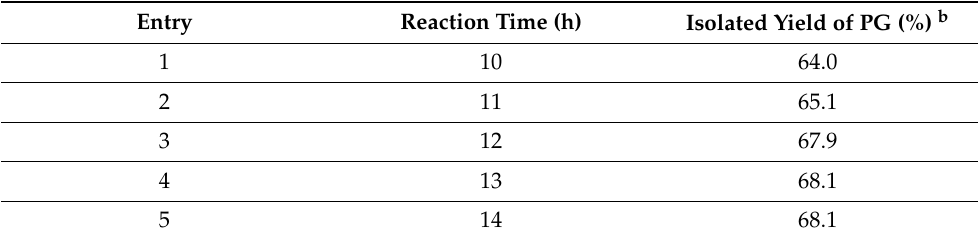
Table 3. Effect of the reaction time on the yield of propyl gallate a .